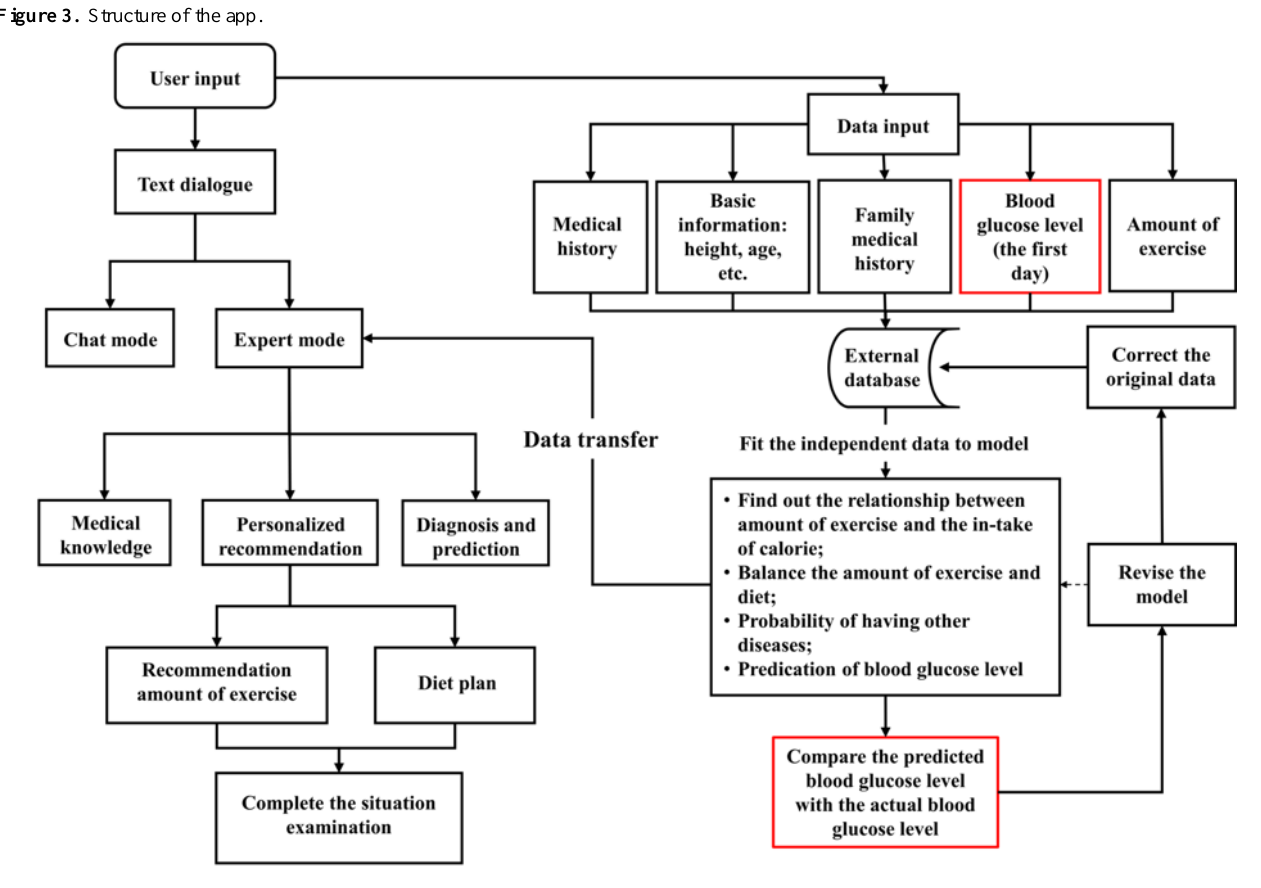
Figure 4. Interface of the